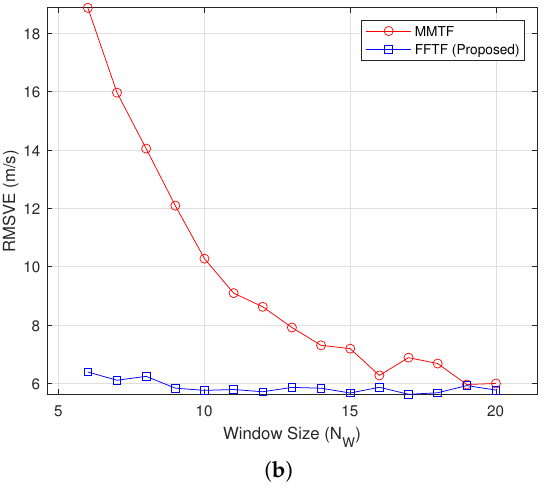
Figure 5. Simulation results under getting farther scenario ( V r = + 20 km/h): ( a ) RMSPE; ( b ) RMSVE.